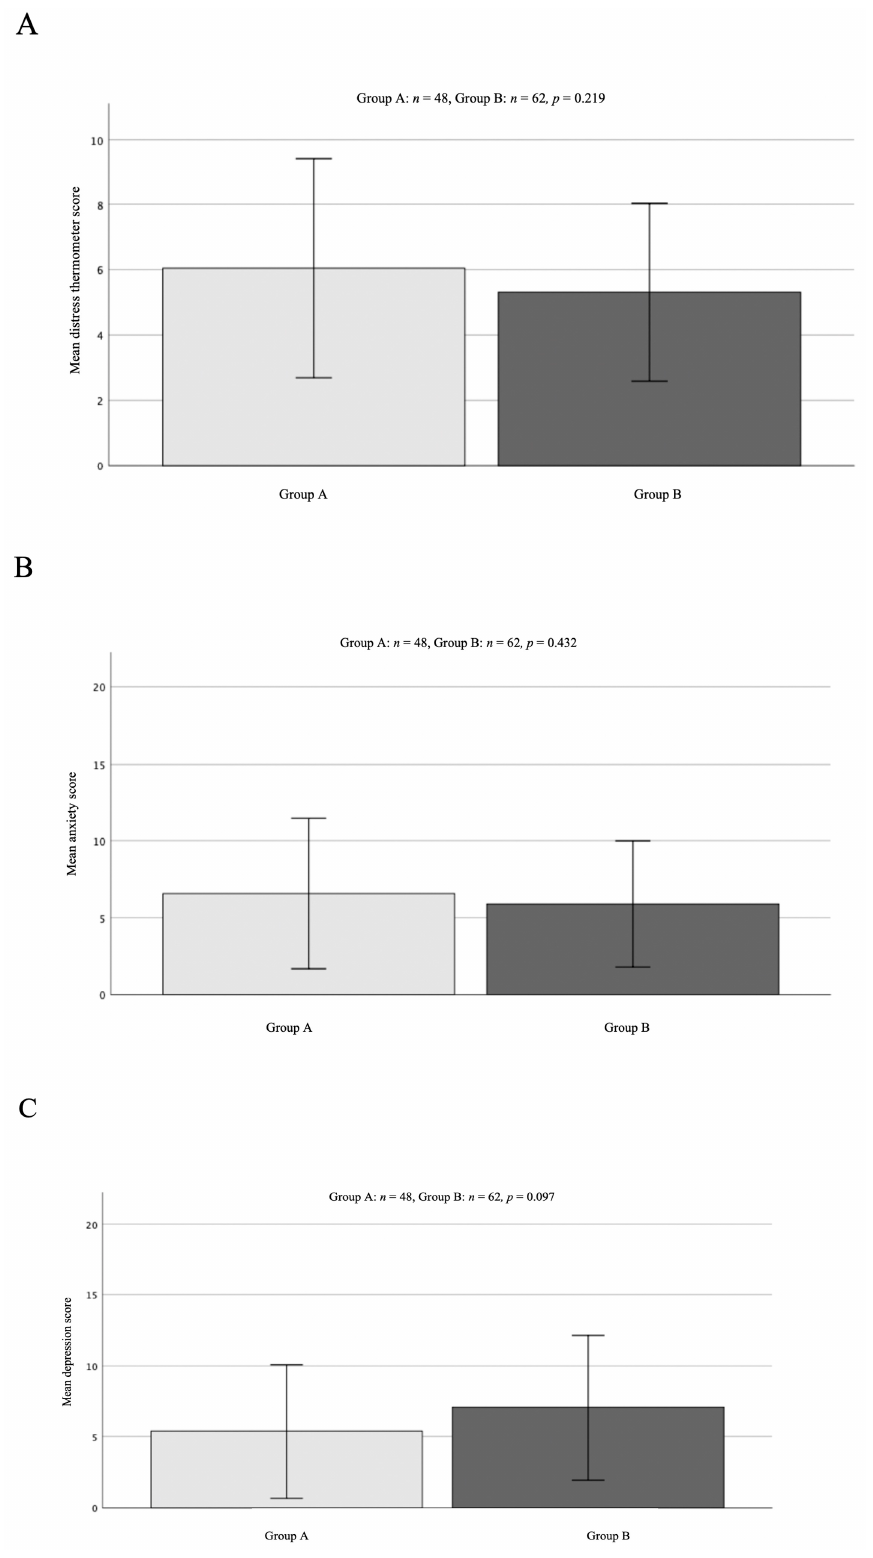
Figure 1. Mean group scores of DT ( A ) and HADS ( B , C ) in both cohorts. Mean depression score ( C ) was slightly higher in the COVID-19 cohort; interestingly, DT ( A ) and anxiety ( B ) scores were even higher in the pre-COVID-19 cohort. All results were not significant. p -values are stated for each single group